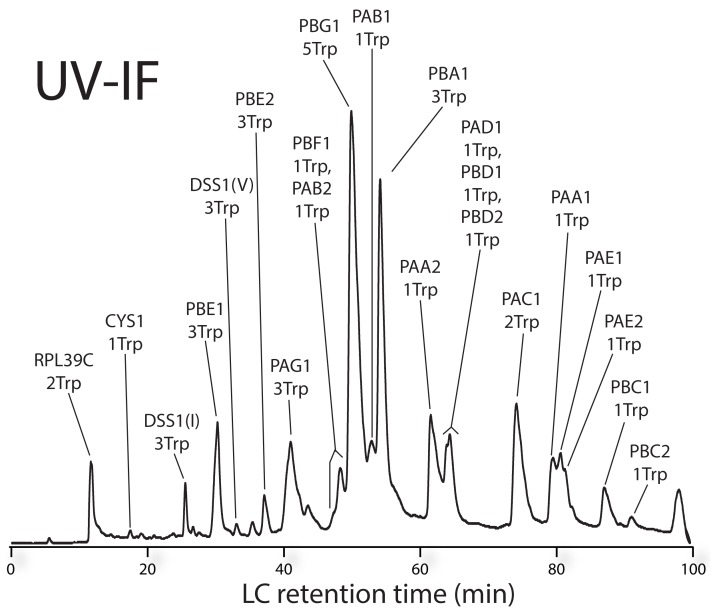
UV-IF chromatogram of affinity-purified 20
S proteasome sample from 
A. thaliana
. Trp-containing proteins identified using MS/MS with assignment to UV-IF peaks.